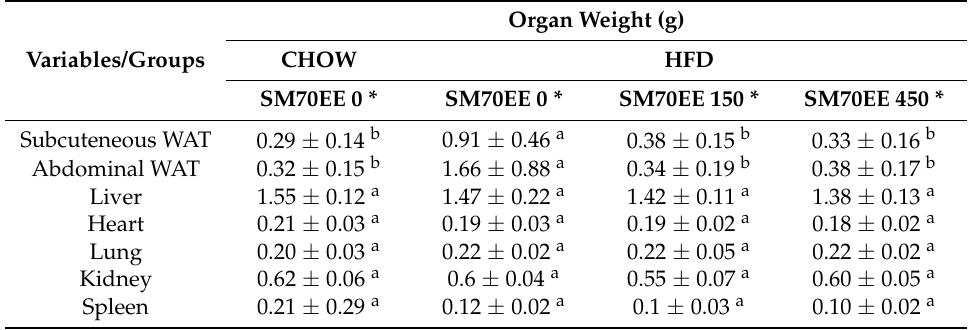
Table 3. Effect of SM70EE administration on organ weight in HFD-fed obese mice for 6 weeks. Organ Weight (g) CHOW Variables/Groups